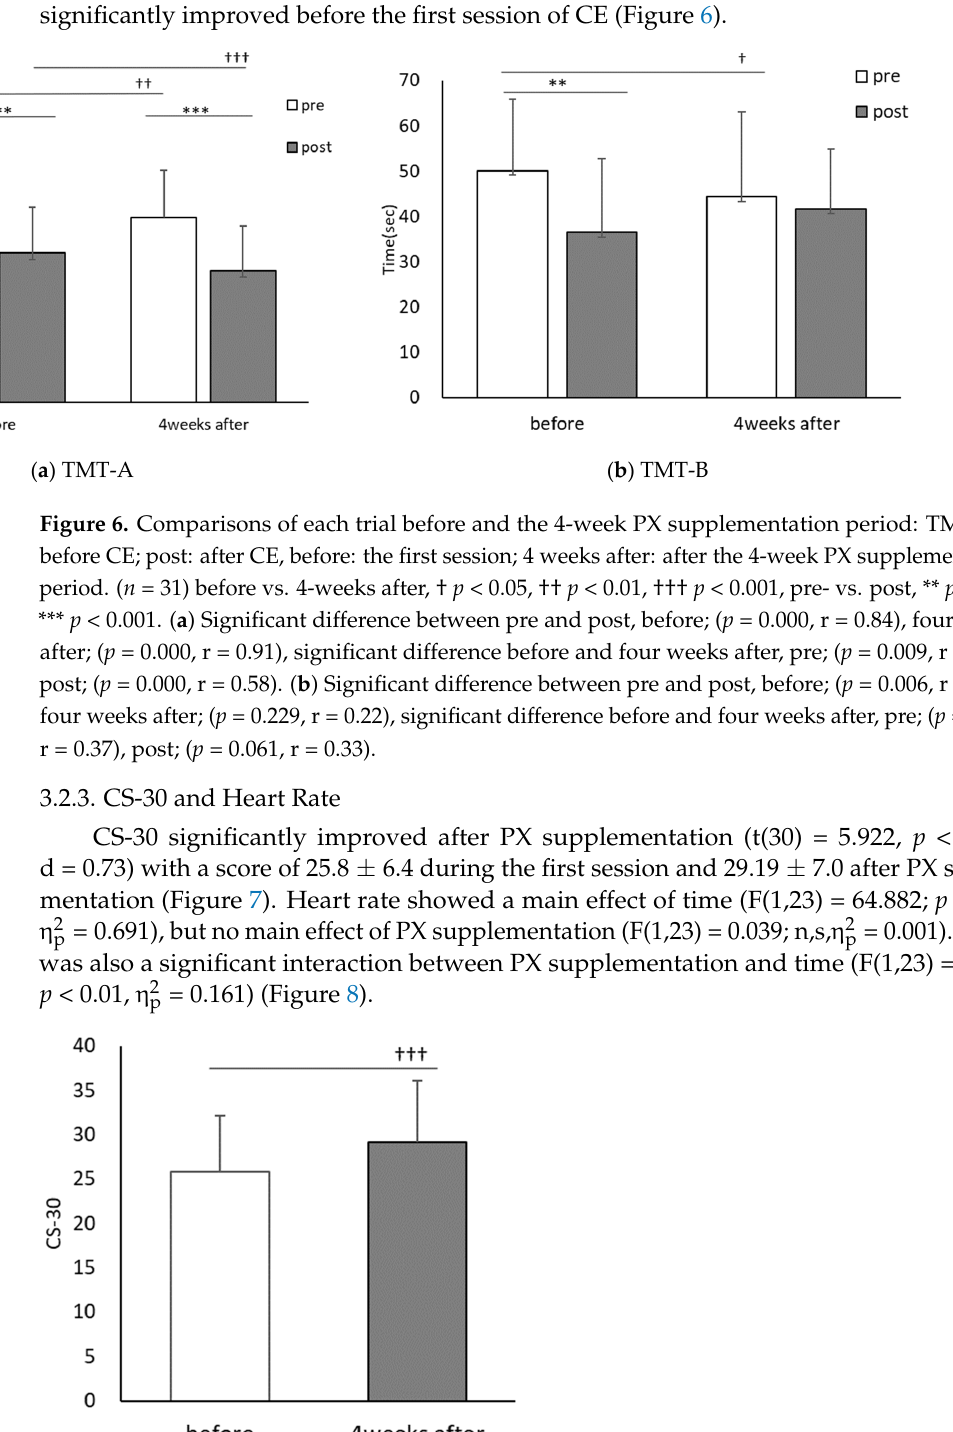
Figure 8. Heart rate across each point for before and after the 4-week PX supplementation period. Data were analyzed using two-way ANOVA. HR: heart rate, rest: before exercise, CS-30; immedi- ately after CS-30 exercise, CE: during Co-kara exercise, post; after Co-kara exercise. CE was meas- ured using the wearable activity monitor. There was a main effect of time ( p < 0.01) and an interac- tion ( p < 0.01). 3.2.4. Changes in the TMT Score before and after PX Supplementation The correlation between lifestyle factors and the changes in the TMT scores before and after PX supplementation are shown in Table 2. Significant correlations were found for the following two items: “Exercise habit of lightly sweating for more than 30 min at least two days a week for more than one year (Exercise habit)” (r = − 0.455, p < 0.05) and “Skip breakfast” (r = 0.362, p < 0.05) . Comparison between groups by a t-test for each of these factors showed significant differences in relation to the presence of exercise habit and the rate of change in the post-exercise TMT-B score after four weeks ( p < 0.05) and no